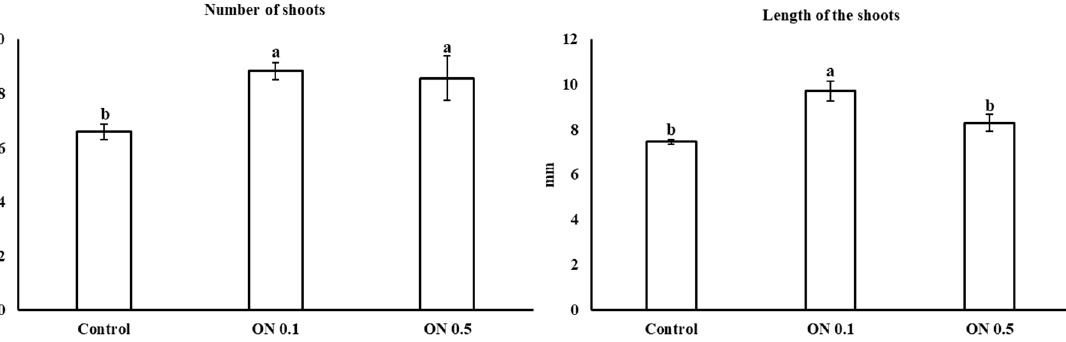
Figure 3. Means of number and length of shoots obtained in the three subsequent subcultures. Means values followed by di ff erent le tt ers were signi fi cantly di ff erent (Tukey HSD test, p < 0.05).